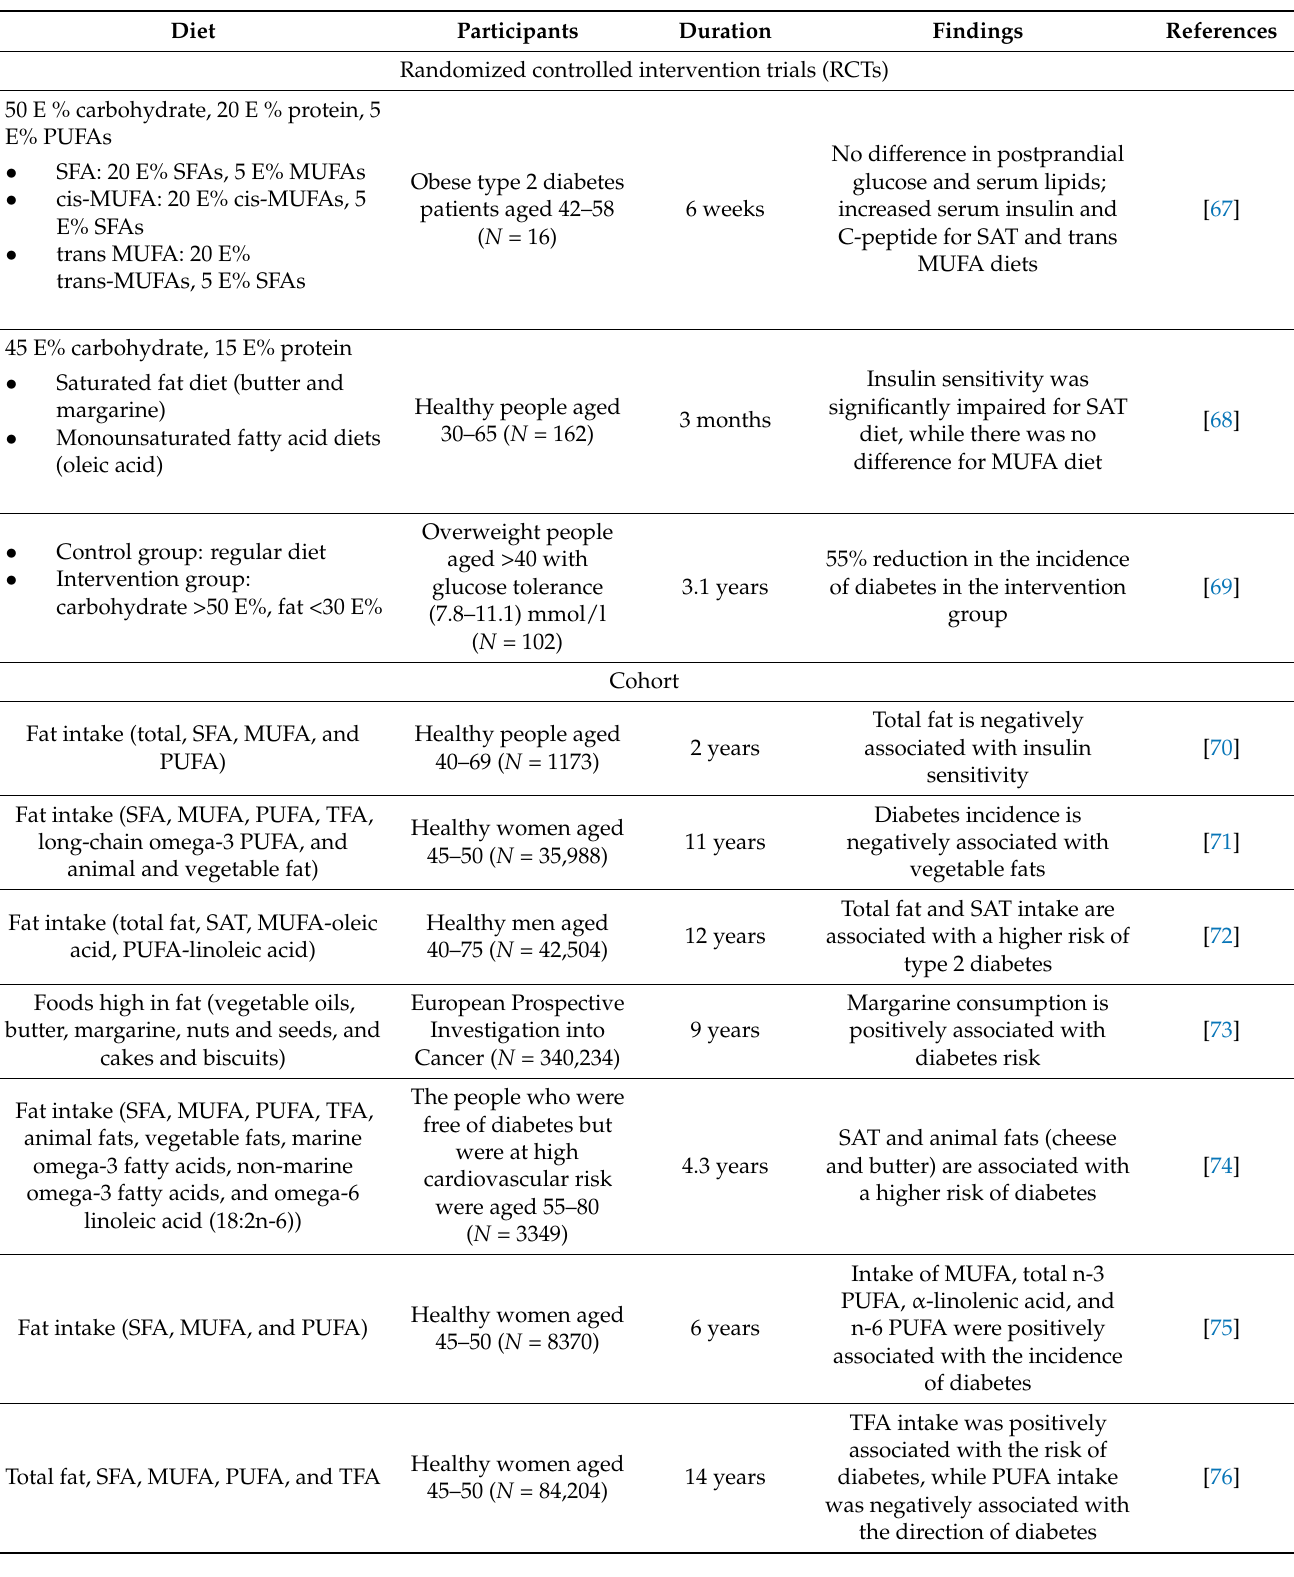
Table 1. High-fat diet and human diabetes intervention